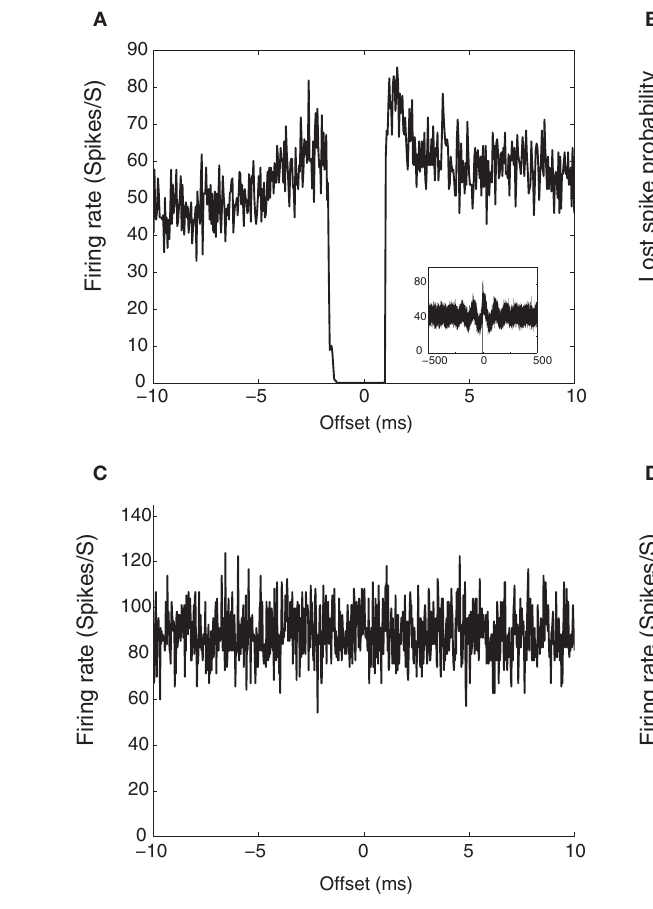
Figure 1 | The shadowing effect – demonstration, quantification, and artificial shadowing. (A) Cross correlation function of a pair of neighboring pallidal neurons (i.e., extracellularly recorded by the same electrode, Monkey Cu). The shadowing effect is approximately within 1 ms offset. This pair also exhibits synchronous oscillations, as can be seen in the larger time scale ( ± 500 ms) cross correlation histogram in the inset. (B) Mean shadowing effect, as estimated from